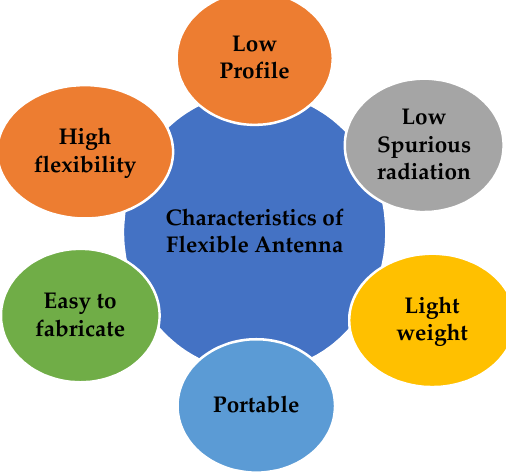
Figure 1. Characteristics of a flexible antenna.